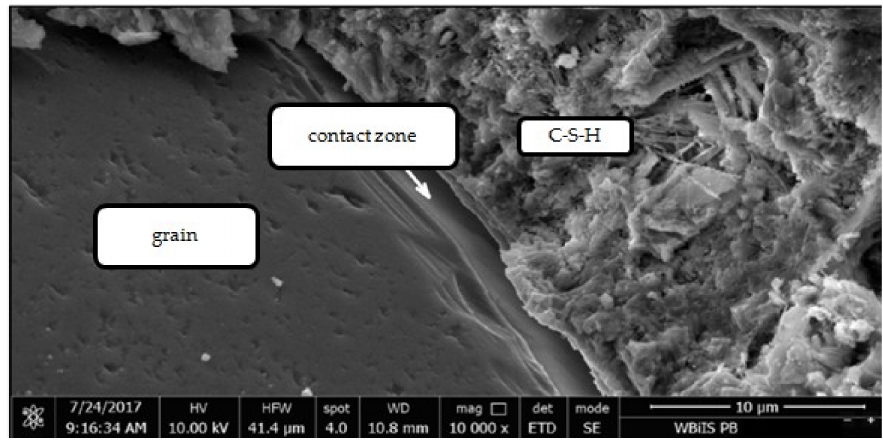
Figure 20. Contact zone between natural gravel aggregate and cement paste.